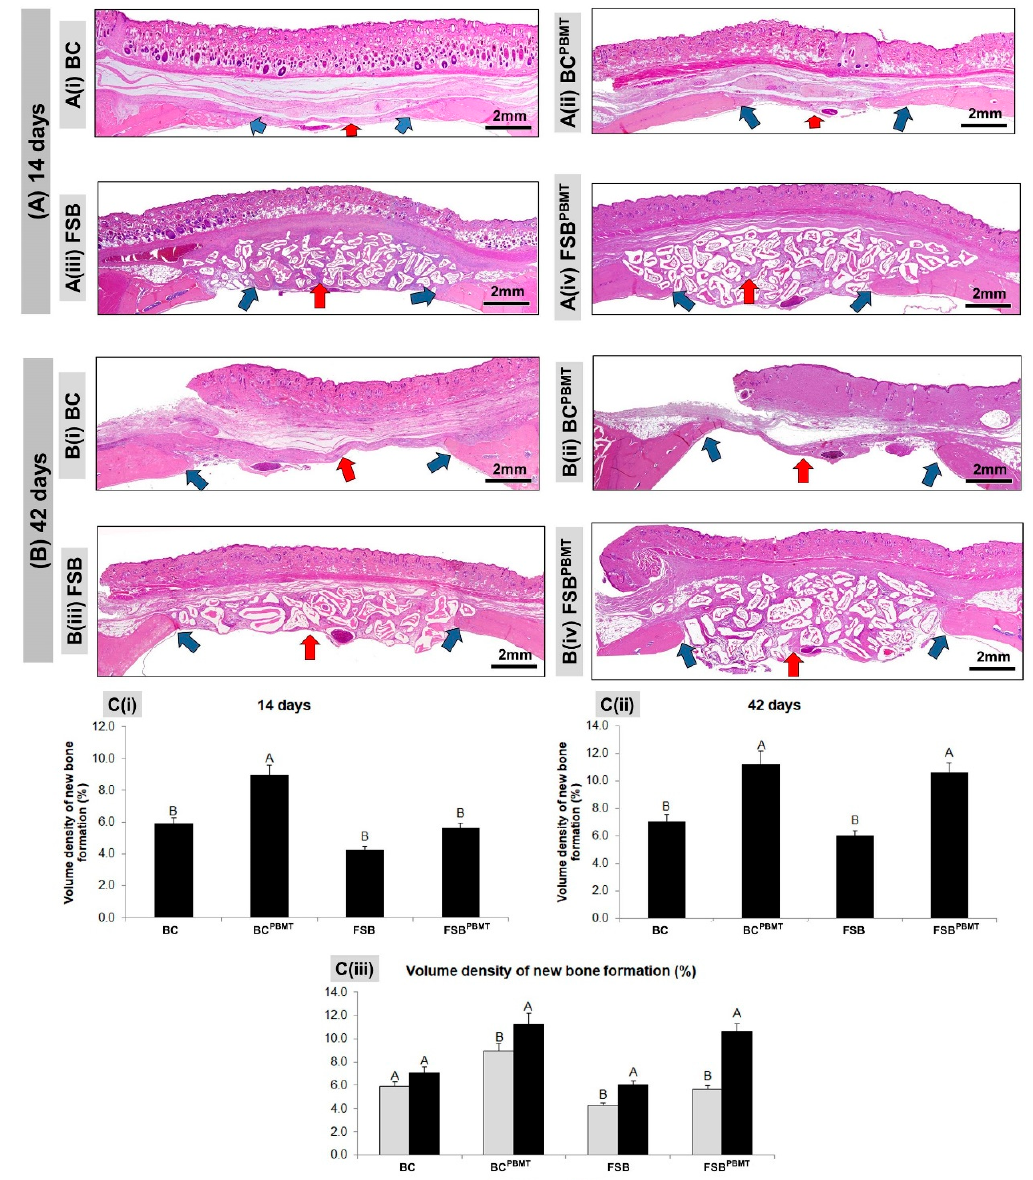
Figure 2. Panoramic histological views at ( A ) 14 days; and ( B ) 42 days, respectively; ( C ) graphs of volume density of newly formed bone in skull defects filled with a blood clot or fibrin sealant plus xenograft and with or without laser photobiomodulation therapy. ( A ) A(i)–A(ii) bone formation (blue arrows) occurring at the defect border and under the dura mater surface. A(iii)–A(iv): the defect showed trabecular bone formation (blue arrows) adjacent to the defect border, in a more advanced stage of bone maturation. ( B ) B(i)–B(ii) both groups showed similar bone formation limited to the defect border and a large region filled with fibrous connective tissue (red arrows); B(iii)–B(iv) a large part of the defect was filled by connective tissue and biomaterials (red arrows), but in the FSB PBMT group, greater bone formation defect could be observed compared to the FSB group; ( C ) Graphs of newly formed bone showed smaller bone formation in the non-biostimulated group (BC and FSB) than the biostimulated group (BC PBMT and FSB PBMT ). (BC and BC PBMT : N = 4/group and periods), (FSB and FSB PBMT : N = 5/group and periods). C(i) and C(ii) where different letters (A ≠ B) indicate a statistically significant difference between groups in the same period and C(iii) where the different letters (A ≠ B) indicate a statistically significant difference in the same group in the two periods analysed ( p < 0.05). (HE; original magnification × 4; bar = 2 mm).